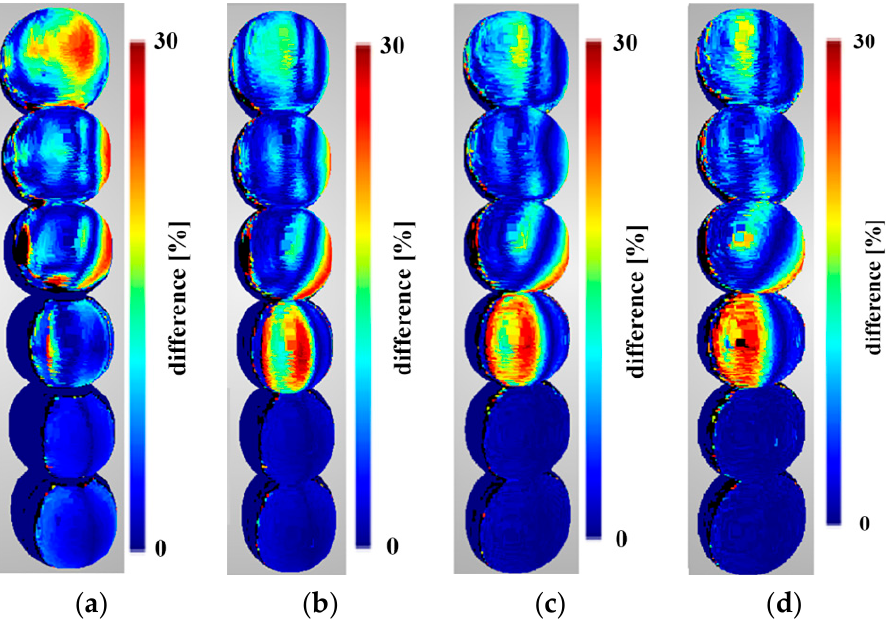
Figure 12. The relative difference between the predictions and evaluations of the density of the reconstructed sphere at the following distances: ( a ) 2 m, ( b ) 3 m, ( c ) 4 m, and ( d ) 5 m. Spheres in different rows were reconstructed from scenarios with different numbers of cameras. In order from bottom to top, these were as follows: two-, three-, four-, six-, nine-, and twelve-camera scenarios. Values higher than 30% are marked in